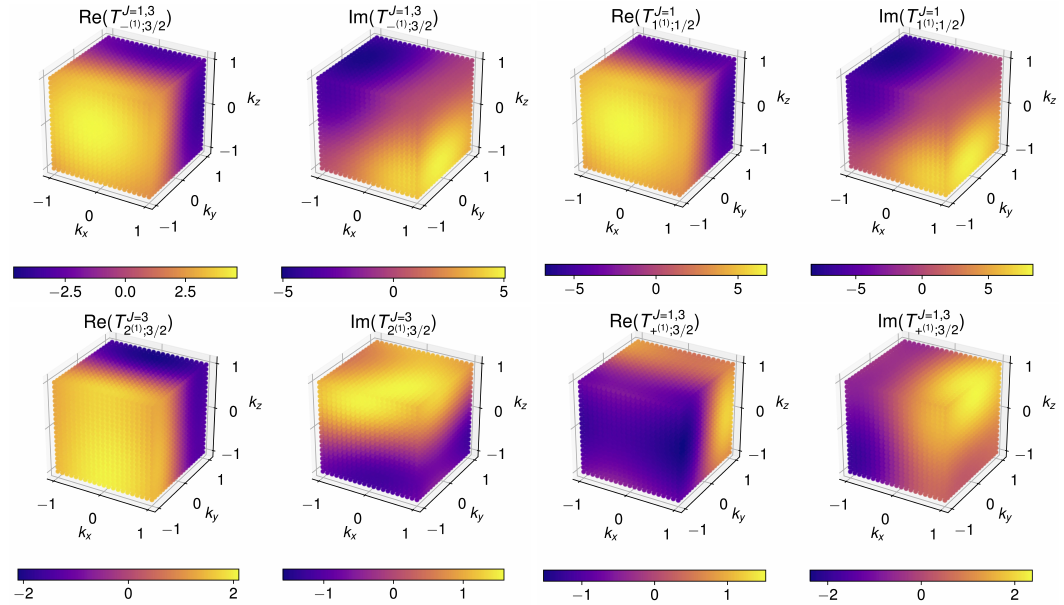
Figure 7: Momentum space distribution of the superconducting states ( j = 1 com- ponent) arising from the novel Kondo interaction presented in Table 2 and Fig.